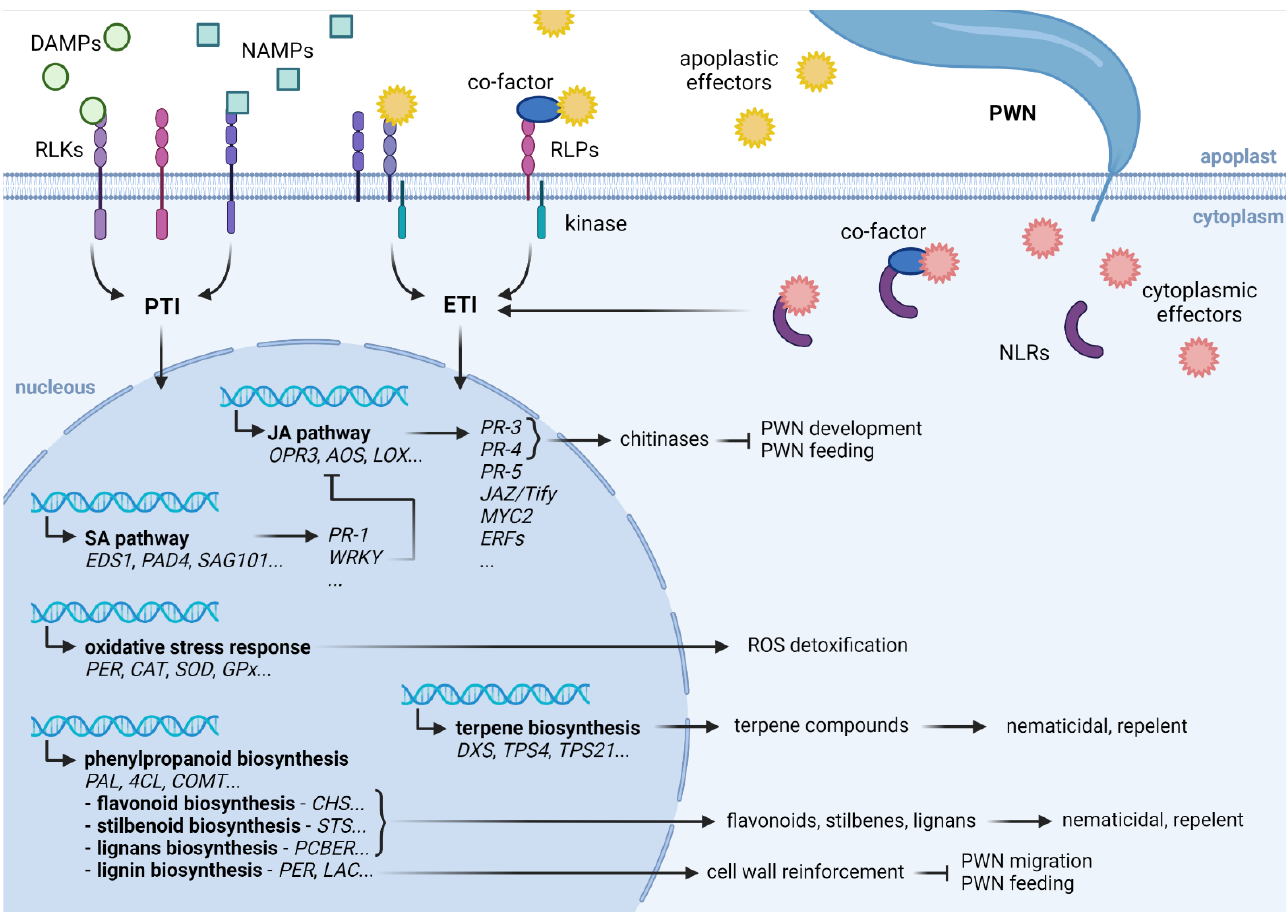
Figure 1. Representation of pine defense response to pinewood nematode (PWN). Pattern-triggered immunity (PTI) is initiated after recognition of nematode-associated molecular patterns (NAMPs), such as BxCDP1, or damage-associated molecular patterns (DAMPs) from damaged plant cells, by cell surface receptor-like kinases (RLKs) or receptor-like proteins (RLPs). PTI leads to a transcriptional reprograming of the plant cell, which includes the activation of hormone pathways, such as jasmonic acid (JA) and salicylic acid (SA) pathways, the expression of pathogenesis-related genes (PR), genes involved in oxidative stress response, and genes encoding enzymes involved in the biosynthesis of secondary metabolites (terpenes and phenylpropanoids). In susceptible plants, it is possible that the activation of the SA pathway inhibits the JA pathway. PWN releases effectors, such as the apoplastic VAP1 and BxSapB1, that repress the plant defense response. These effectors may be recognized by resistance genes, whether directly or indirectly through the monitoring of a co-factor protein that is altered by the effector. Effectors can be recognized by cell surface receptors, when they are apoplastic, or internal nucleotide-binding/leucine-rich-repeat (NLR) receptors, when they are injected into the cytoplasm by the PWN. Recognition of effectors by resistance genes initiates a stronger and more sustained defense response, the effector-triggered immunity (ETI).